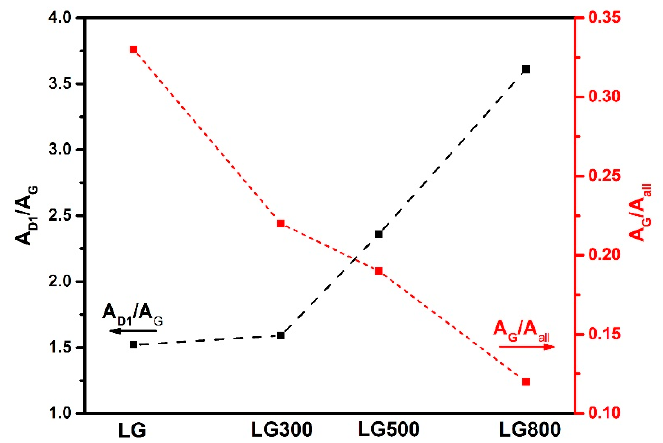
Figure 4. A D1 /A G and A G /A all area ratios for all fuels.